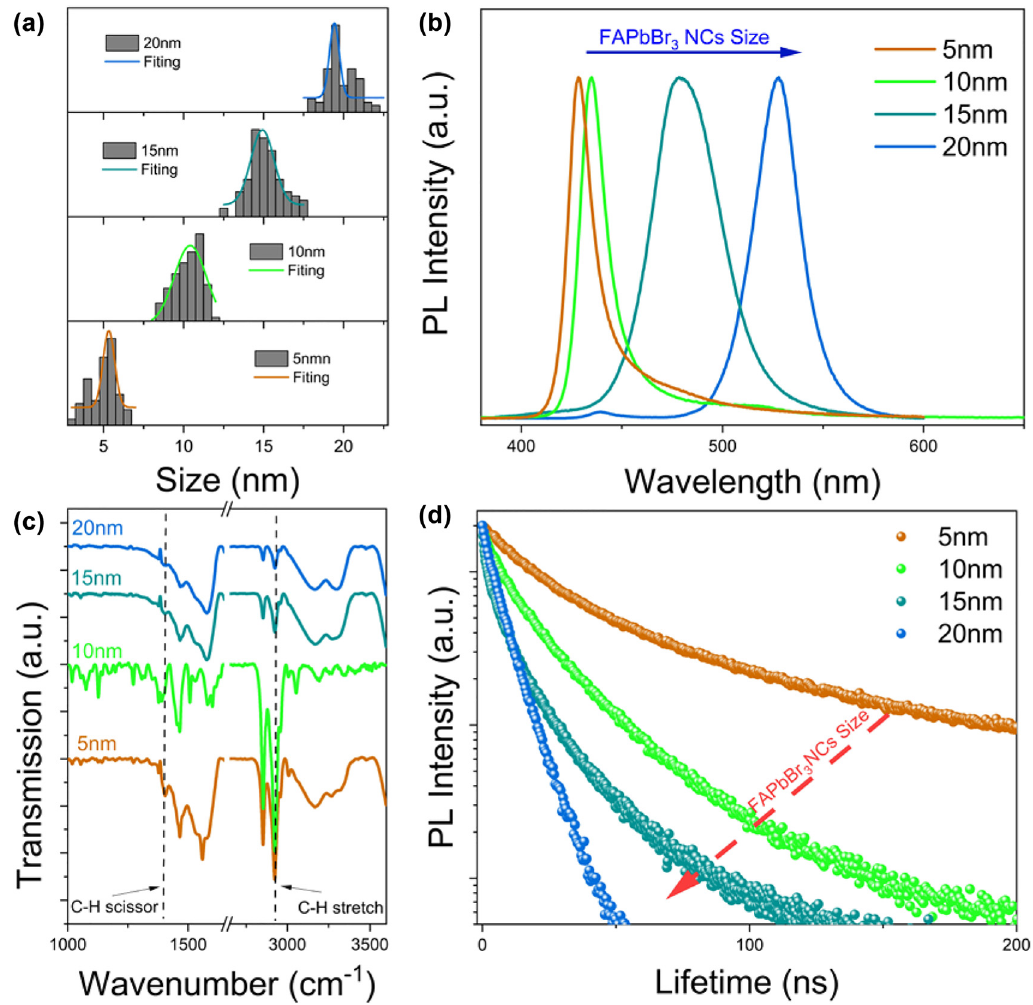
Figure 3: Characterization of NEA coated FAPbBr3 NCs with different particle sizes. (a) Particle size distribution histogram of four NEA-coated NCs; (b) photoluminescence spectra of NEA-coated FAPbBr FAPbBr 3 FAPbBr NCs showing the presence of the characteristic bond of the NEA ligands; (d) time-resolved photoluminescence spectra of FAPbBr 3 NCs with four particle